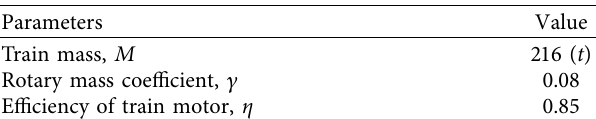
Figure 7: Te illustration of speed restriction and gradient changing. Table 3: Train